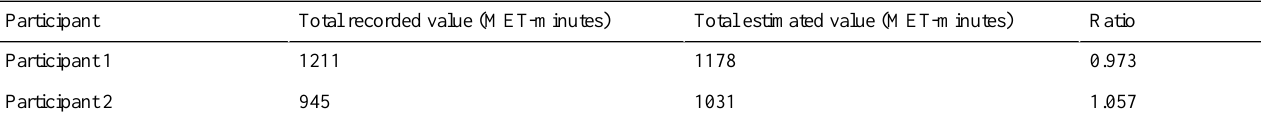
Table 3. Result of total recorded physical activity and total estimated physical